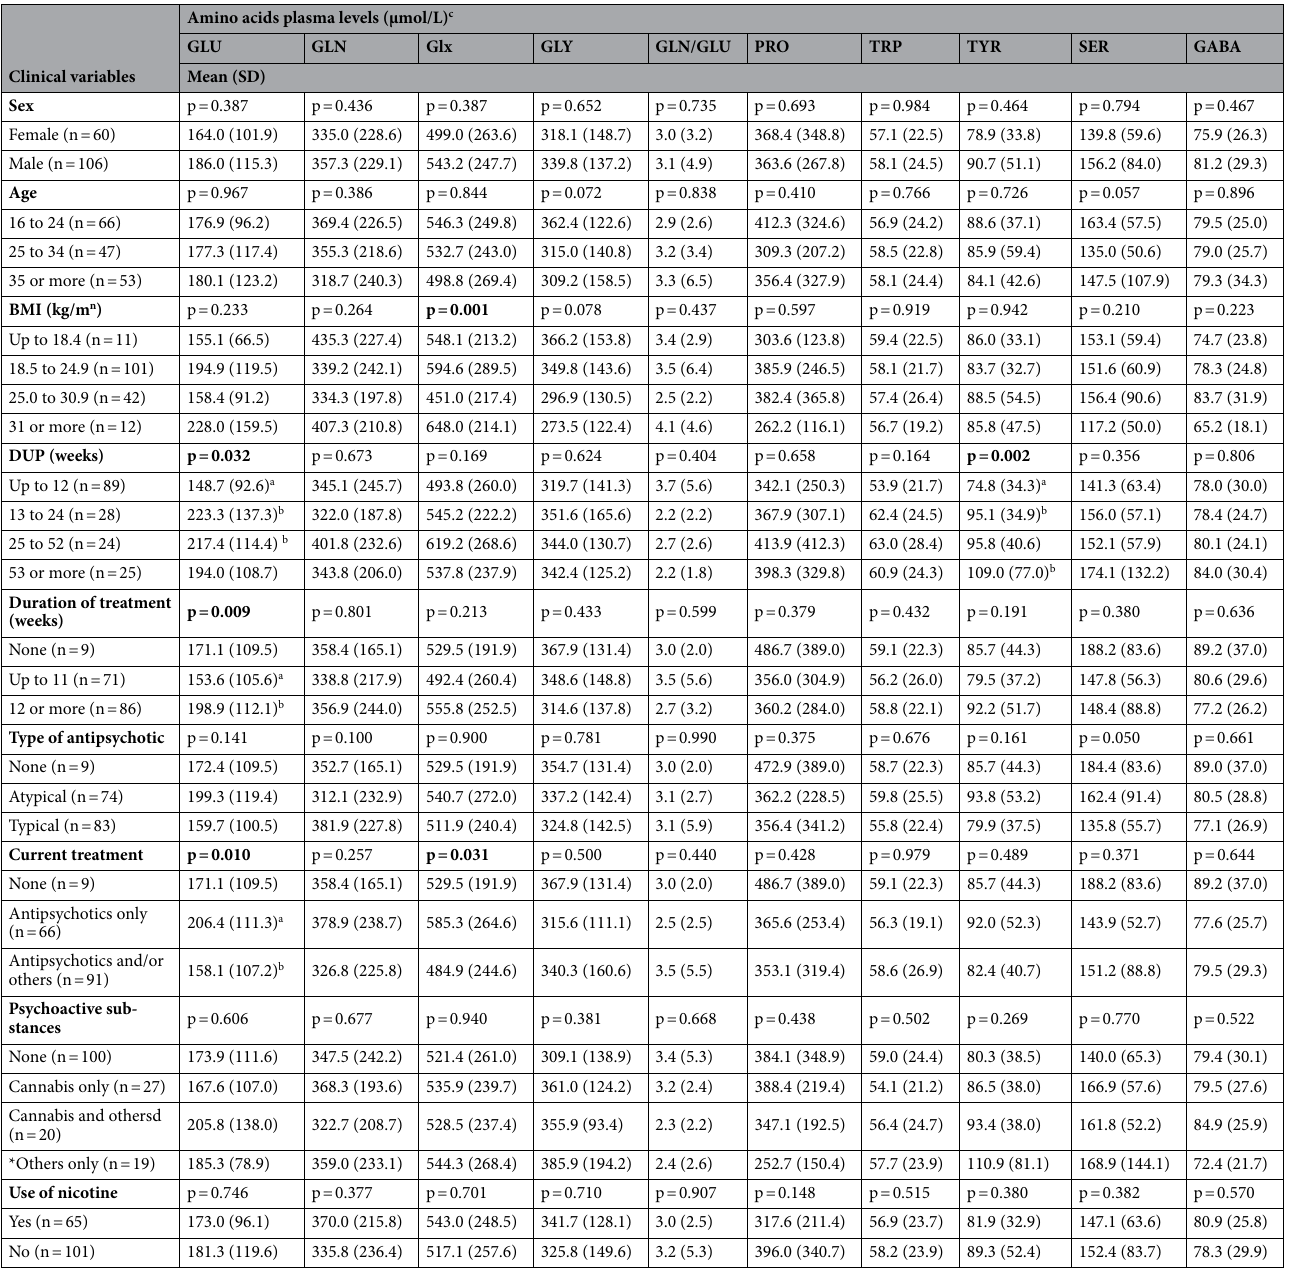
Table 3. Differences between amino acid plasma levels in relation to clinical variables in FEP patients. GLU glutamic acid, GLN glutamine, GLY glycine, PRO proline, TRP tryptophan, TYR tyrosine, SER serine, GABA y-aminobutyric, SD standard deviation, BMI Body Mass Index, DUP duration of untreated psychosis. Bold: ≤ 0.05. a,b Superscript letters were used for the mean values in the columns, in which the means followed by different letters differ statistically from each other. Multiple comparisons and orthogonal contrasts performed in the GLM with 5% probability. c Generalized Linear Model adjusted by sex, age and BMI analysed with log transformed. d Alcohol, cocaine/crack and